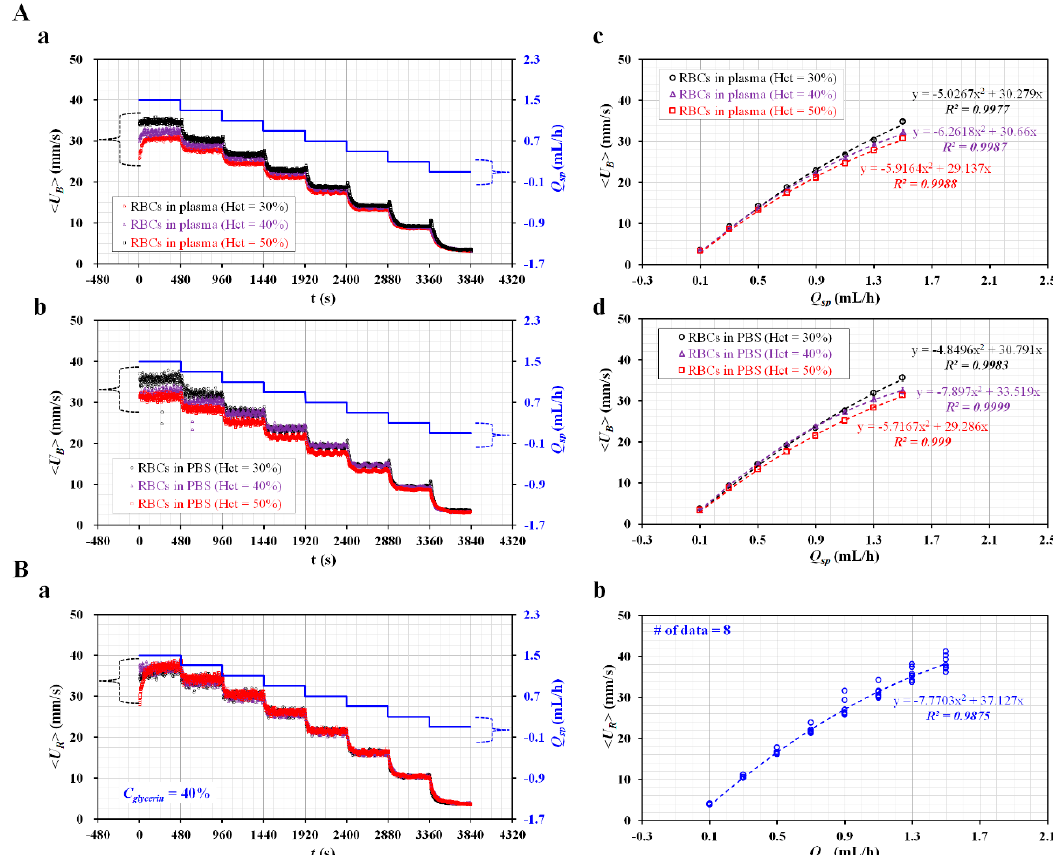
Figure 3. Calibration formula for the relationship between flow rate controlled by SP ( Q sp ) and averaged velocity obtained by µ PIV technique ( < U > ). Hematocrit ( Hct ) of blood was adjusted to Hct = 30%, 40%, and 50% by adding normal RBCs into a base solution (1 × PBS or plasma). With two syringe pumps, the flow rate of each fluid decreased stepwise from Q sp = 1.5 mL / h to Q sp = 0.1 mL / h at an interval of 0.2 mL / h. Each flow rate was maintained for 8 min. ( A ) Relationship between Q sp and < U B > with respect to hematocrit and base solution. ( a ) Temporal variations in < U B > and Q sp of blood sample (normal RBCs in plasma) with respect to Hct . ( b ) Temporal variations in < U B > and Q sp of blood sample (normal RBCs in 1 × PBS) with respect to Hct . ( c ) Regression formula between < U B > and Q sp of blood sample (normal RBCs in plasma) with respect to Hct . ( d ) Regression formula between < U B > and Q sp of blood sample (normal RBCs in 1 × PBS) with respect to Hct . ( B ) Calibration formula of relationship between Q sp and < U R > of reference fluid (40% glycerin solution with RBCs ( Hct = 7%). ( a ) Temporal variations of Q sp and < U R > . ( b ) Regression formula between < U B > and Q sp